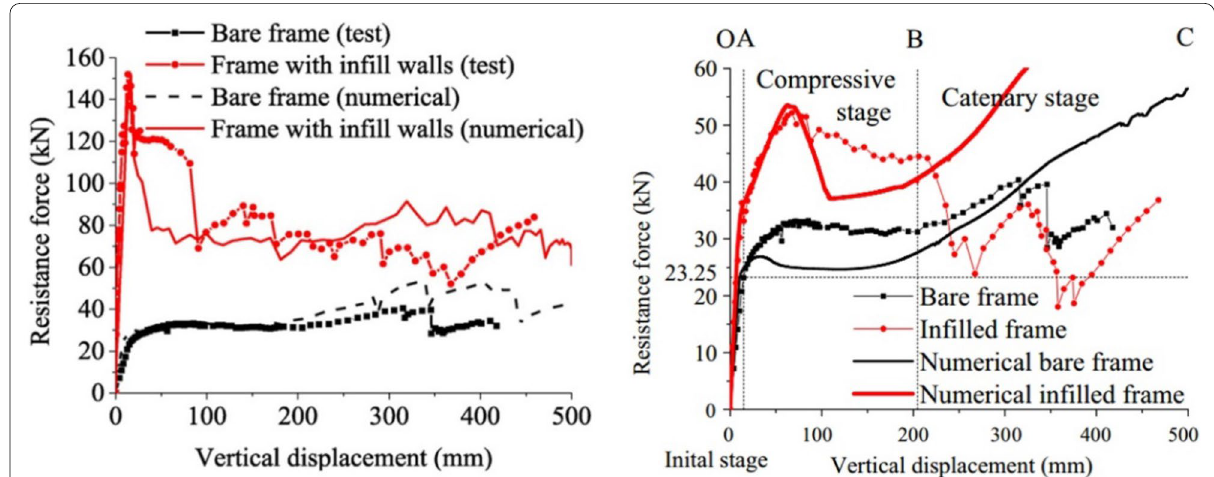
Fig. 3 Resistance force versus vertical displacement in full‑height (left) and partial‑height (right) infill wall frames. Image by courtesy of Shan and Li (Harbin Institute of